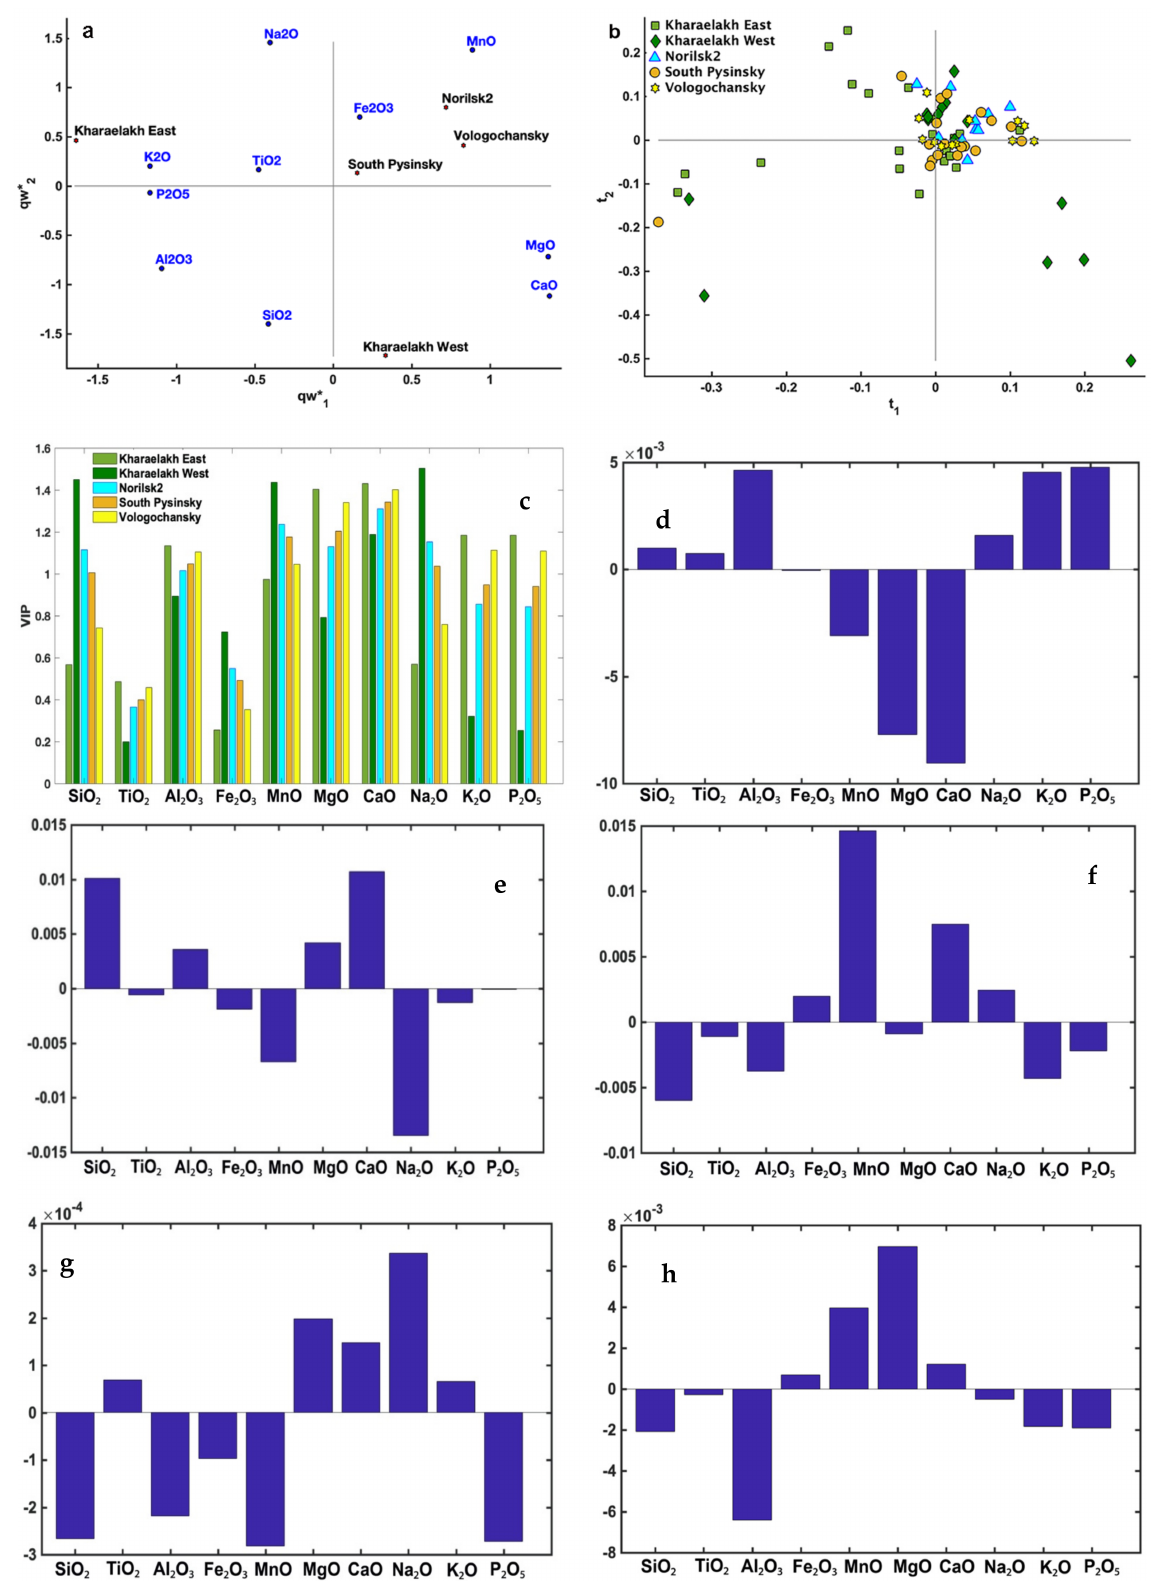
Figure 11. Partial least-squares discriminant analysis (PLS-DA) of the major oxide data from the different studied gabbro– dolerite intrusions. ( a ) The qw* 1 –qw* 2 (first and second loadings) biplot, ( b ) respective t 1 –t 2 plot, ( c ) variable importance on projection (VIP) plot, and score contribution plots for the ( d ) Kharaelakh East, ( e ) Kharaelakh West, ( f ) Norilsk 2, ( g ) South Pyasinsky and ( h ) Vologochansky